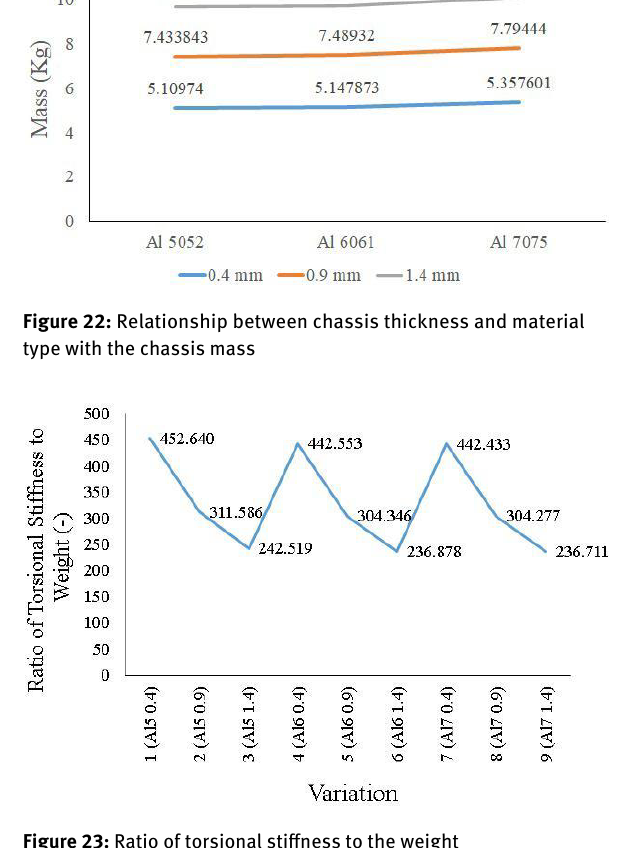
Al 5052, as found in the material properties in Tables 5 to